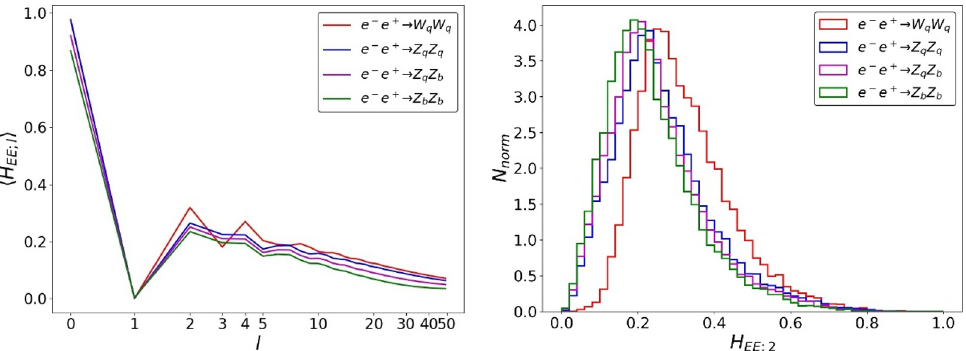
Figure 12 . FW spectra of h H EE ; l i (left) and event distributions of H EE ;2 (right) for the four-jet